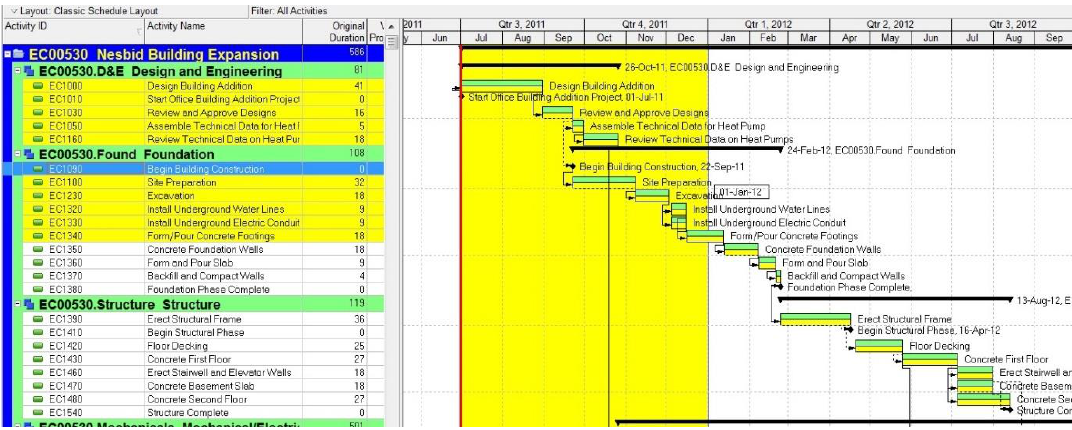
Figure 11. Primavera P6 Progress Spotlight.